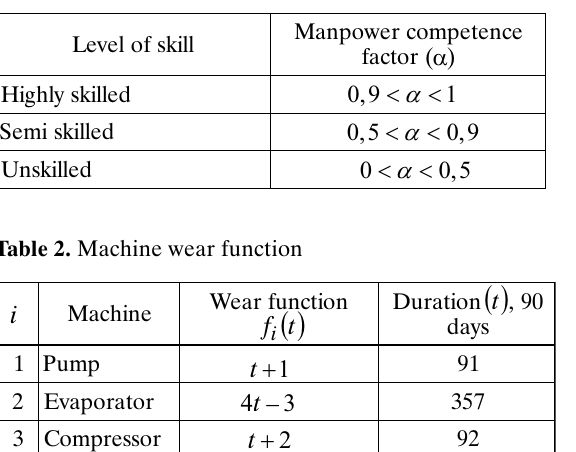
Table 1. Skill level and manpower competence factor